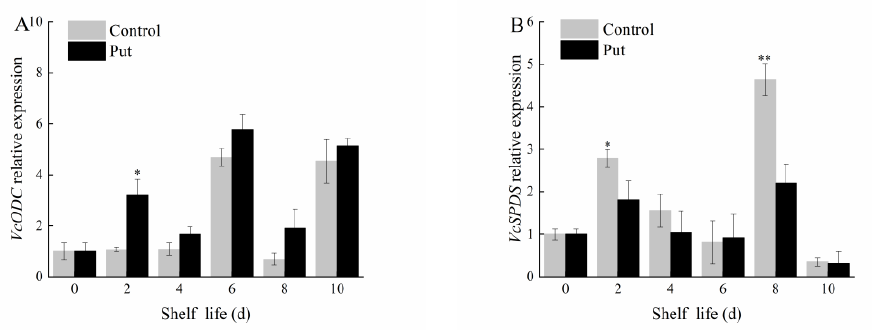
Figure 6. Changes in VcODC ( A ) and VcSPDS ( B ) relative expression of postharvest blueberry fruit at 20 ◦ C. Mean ± SE of three replicate experiments are shown. Asterisks indicate significant differences between control and Put − treated fruit (* p < 0.05, ** p < 0.01).